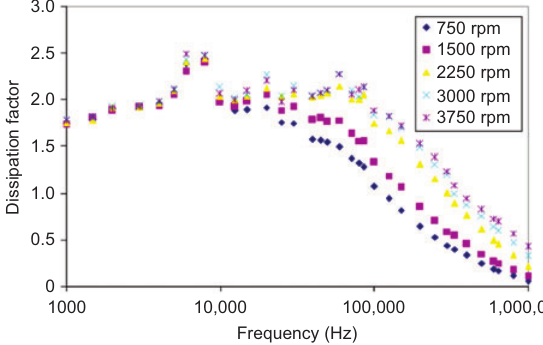
Figure 3 Dissipation factor from 1 kHz to 1 MHz of PVDF com- posites with 10 wt % Ni on PCB substrates using varying spin coating